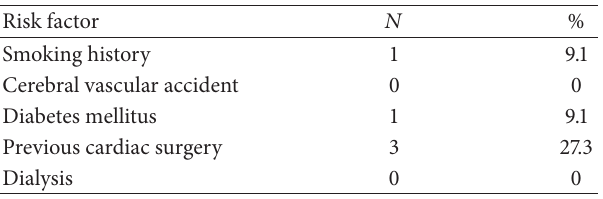
Table 1: Preoperative risk factors.